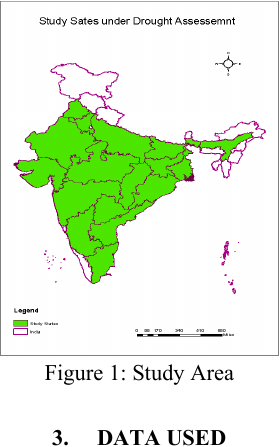
Figure 1: Study Area